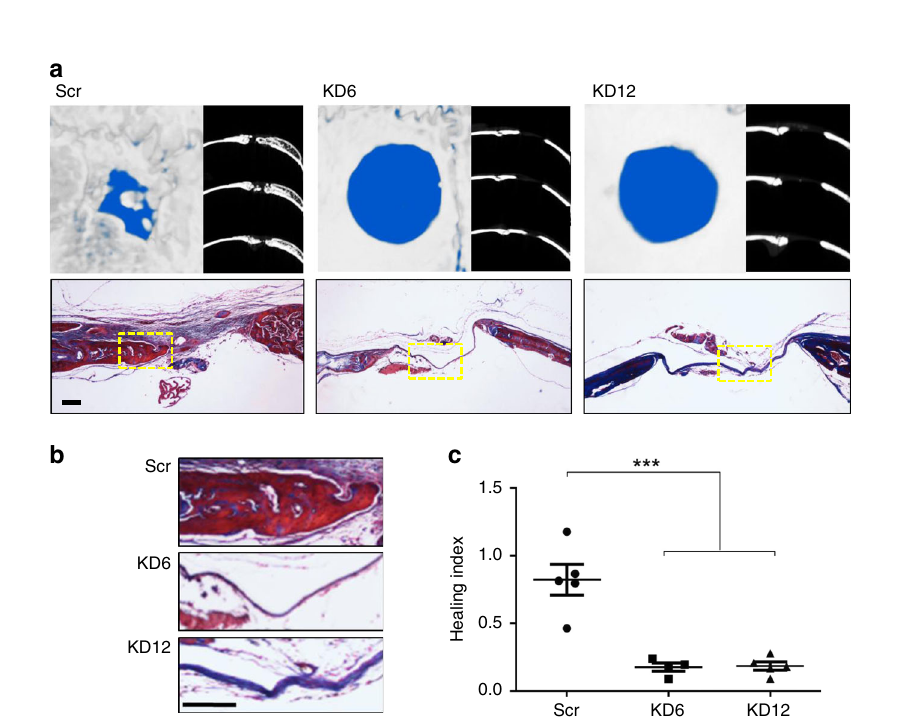
Fig. 5 Knock down of collagen VI or collagen XII transcription results in osteogenic de fi ciencies by OEhMSCs in vivo. Immune-compromised nude mice received a 4 mm diameter, full-thickness circular calvarial defect followed by 2 × 10 6 scrambled, KD6, or KD12 OEhMSCs delivered in clotted plasma. After 4 weeks, calvaria were scanned by μ CT and subjected to histology. a μ CT reconstructions (above left), axial cross-sections (above right), and Masson ʼ s trichrome-stained sections of calvarial specimens after 4 weeks of healing (bar = 250 μ m). b High-power micrographs of healed specimens indicating trabecular micro-structure of newly formed bone (bar = 75 μ m). Yellow boxes in panel a indicate the enlarged region in panel b . c Healing index of defects. Image data representative of fi ve pictures generated from each independent specimen. Statistics: data are presented with means (horizontal line) with SD (error bars). The data were compared using ANOVA with Tukey ʼ s post-test. *** p < 0.005, n = 5 except KD6 where n = 4. Source data are provided as a Source Data fi